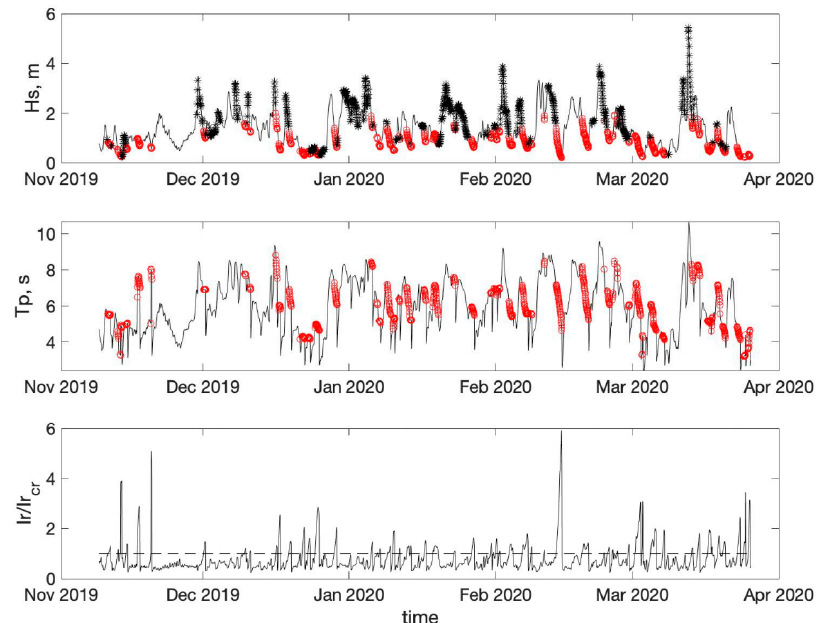
Figure 7. Wave height, peak wave period and ratio between deep water and critical Iribarren number (below the dashed line are regimes with pronounced exchange of energy between wave harmonics). Red circles—wave regimes without pronounced energy exchange between harmonics. Black stars—shore-normal regimes.